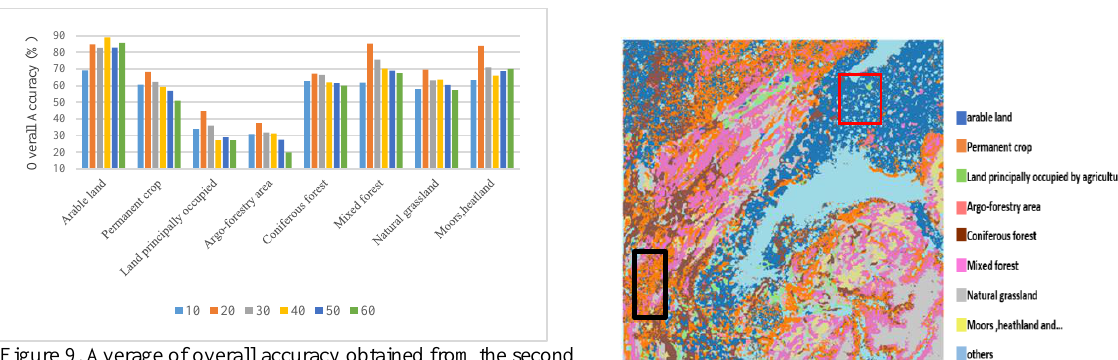
Figure 12. Classification map obtained from ResNet101 at 20 m spatial resolution with fine-tuning